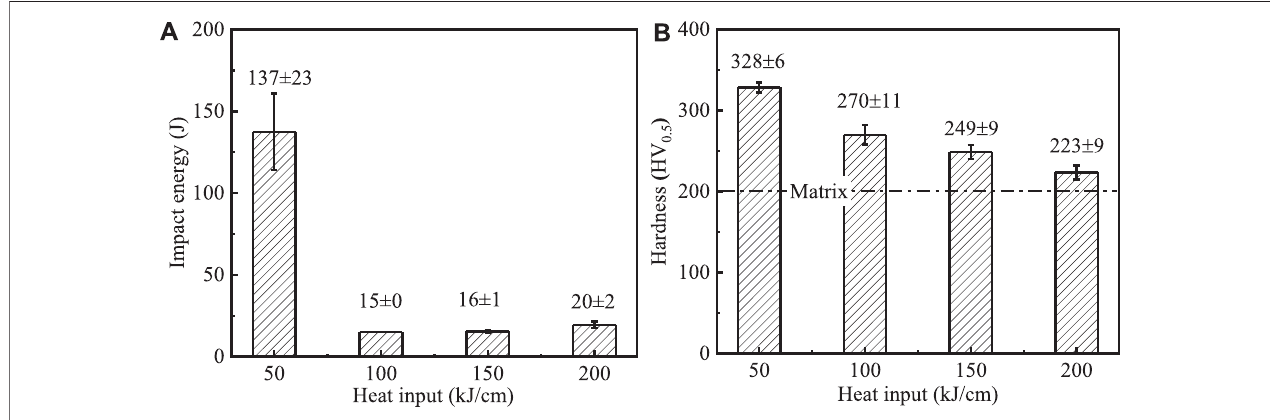
FIGURE 2 | (A) Charpy impact energy at − 40 ° C and (B) microhardness of the CGHAZ at different heat inputs.